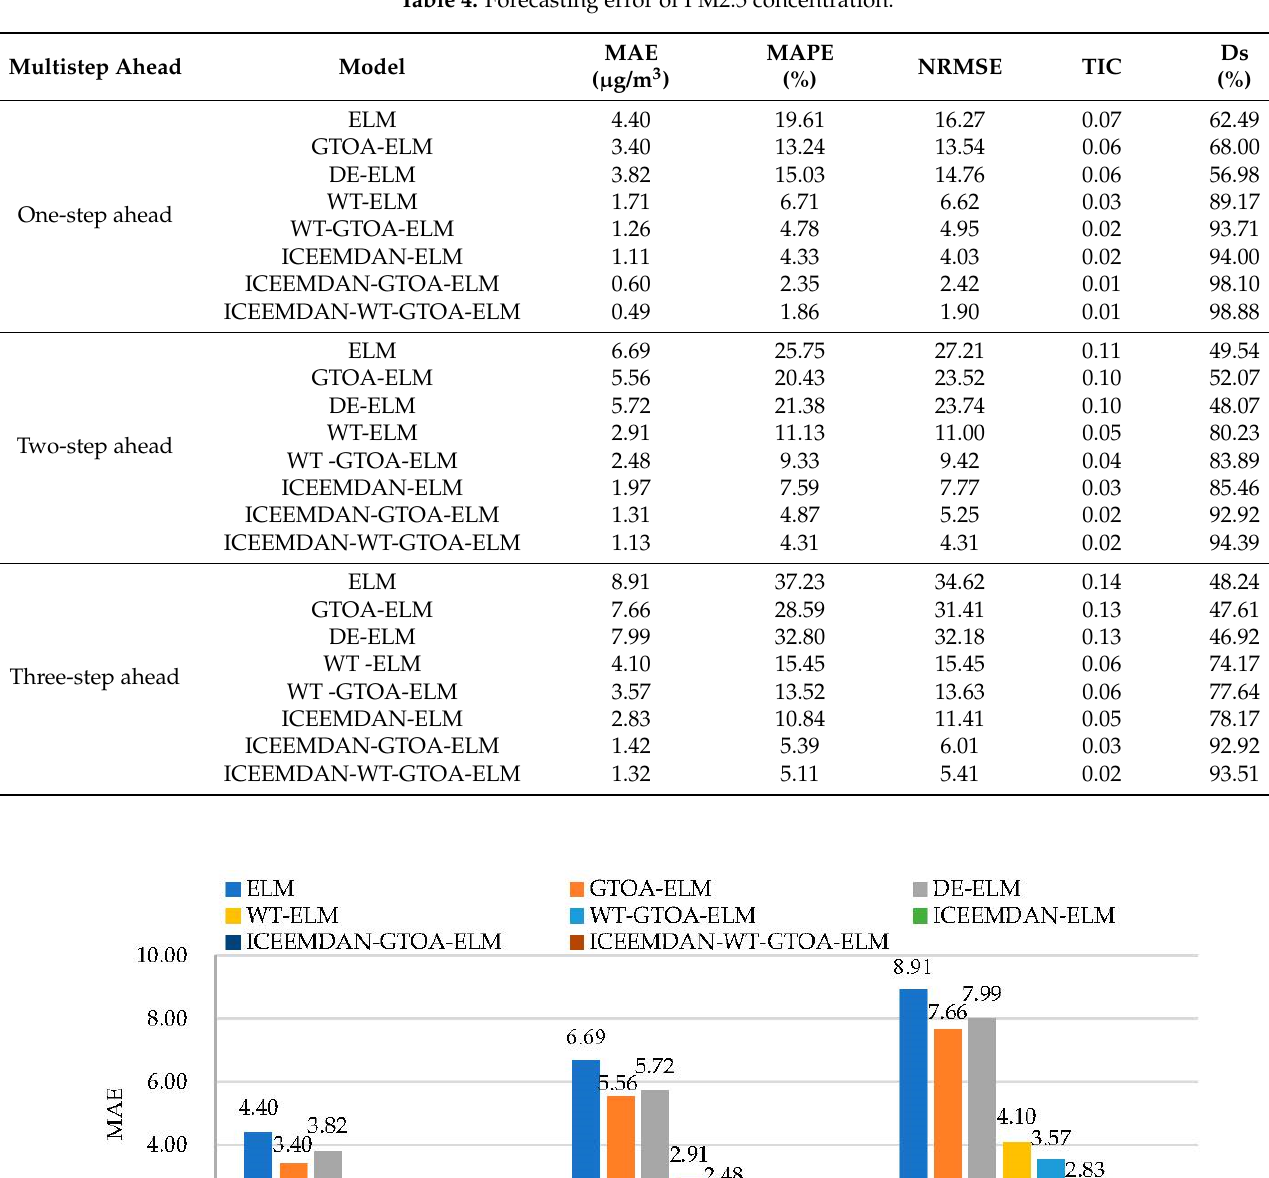
Table 4. Forecasting error of PM2.5 concentration.